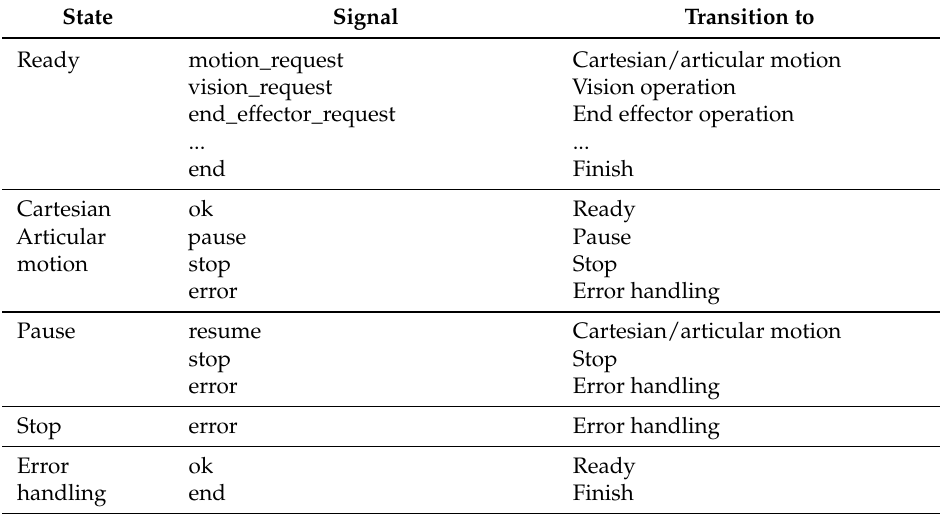
Table 2. Summary of the signals and transitions of the state